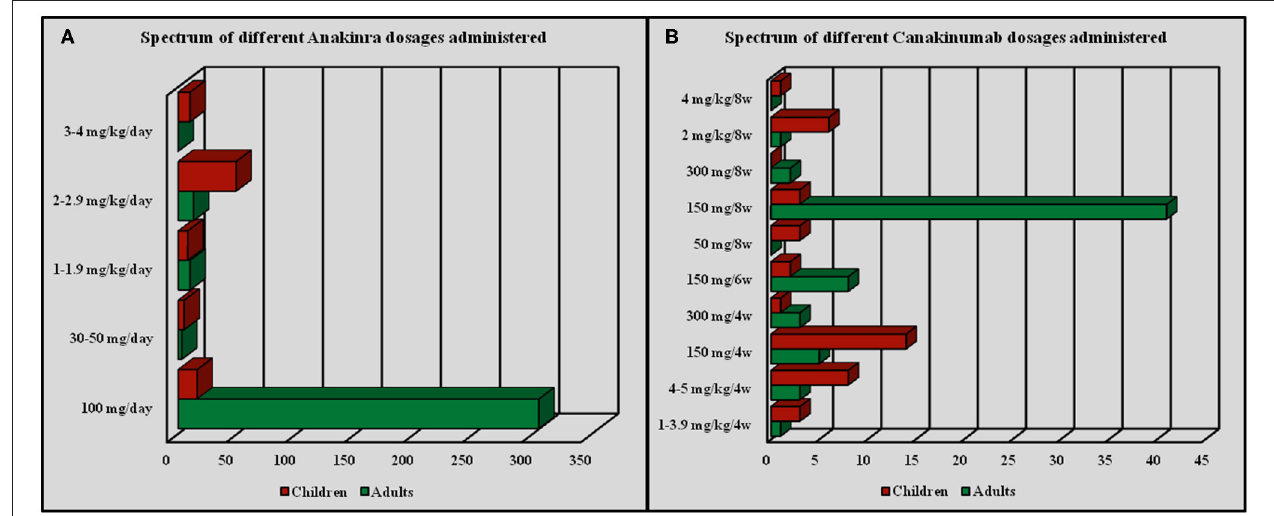
FIGURE 4 | Frequency of administration for different dosages employed with Anakinra (A) and Canakinumab